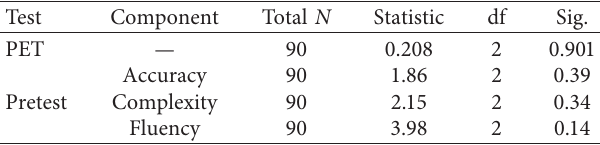
Table 1: Descriptive statistics for the PET, pretest, and post-test ( n �